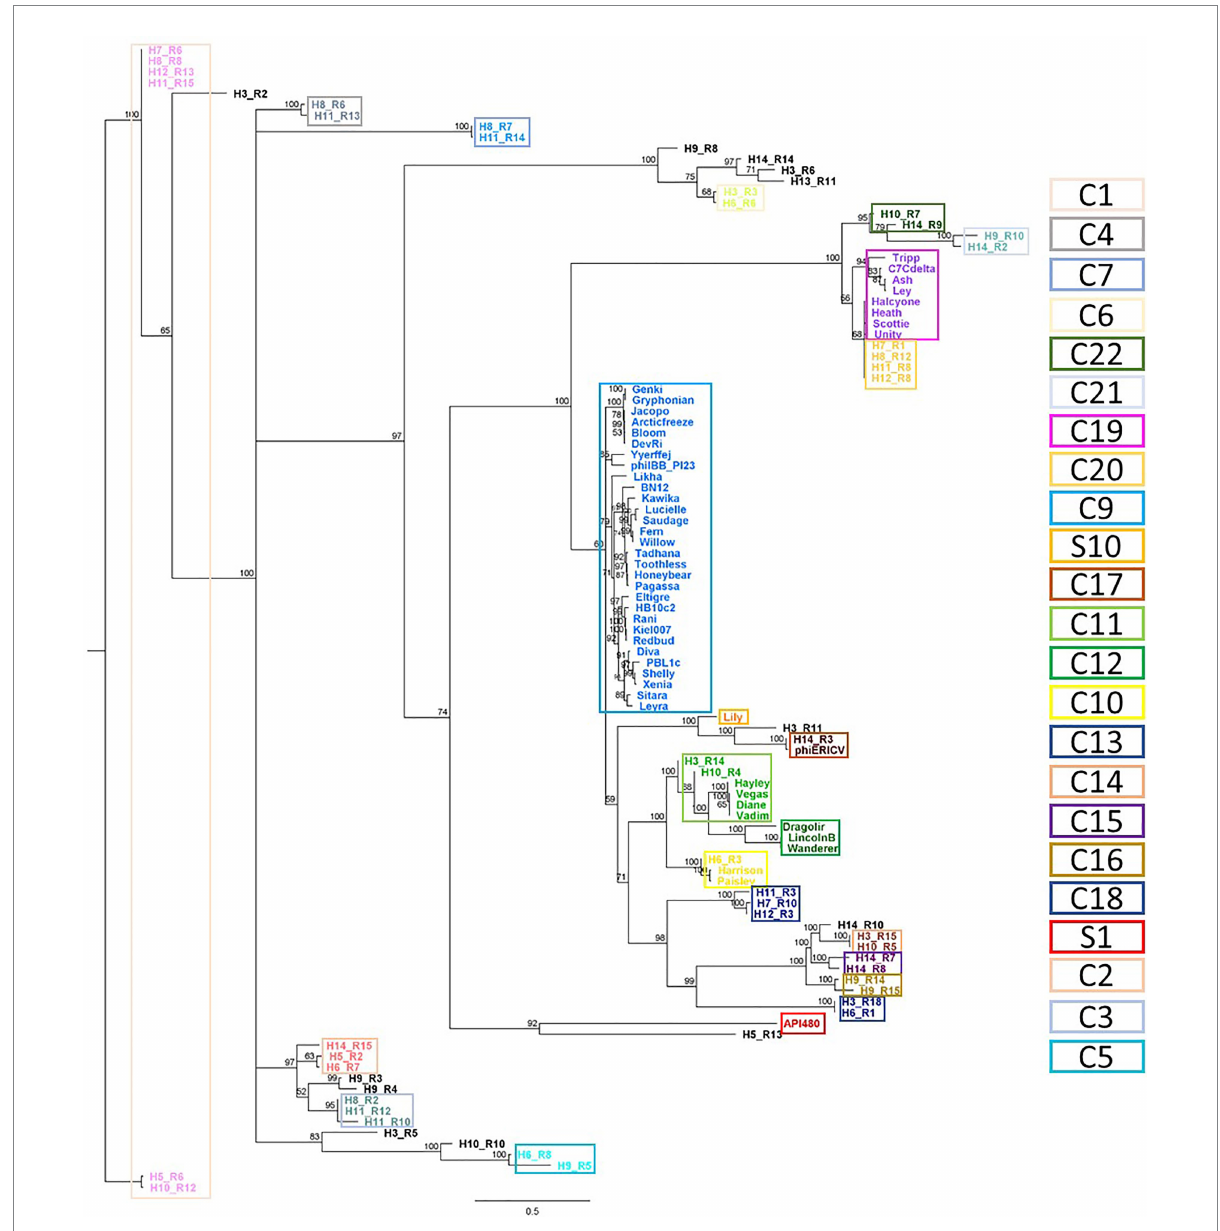
FIGURE 5 Phylogenetic analysis of Paenibacillus larvae phages. Whole genomes based on shared CDS content (nucleotide), obtained with Geneious. Database: Paenibacillus larvae reported phages ( n = 50) and intact Paenibacillus larvae prophages ( n = 55), identified here. Clusters have ≥ 60% of shared CDS and were highlighted by colored